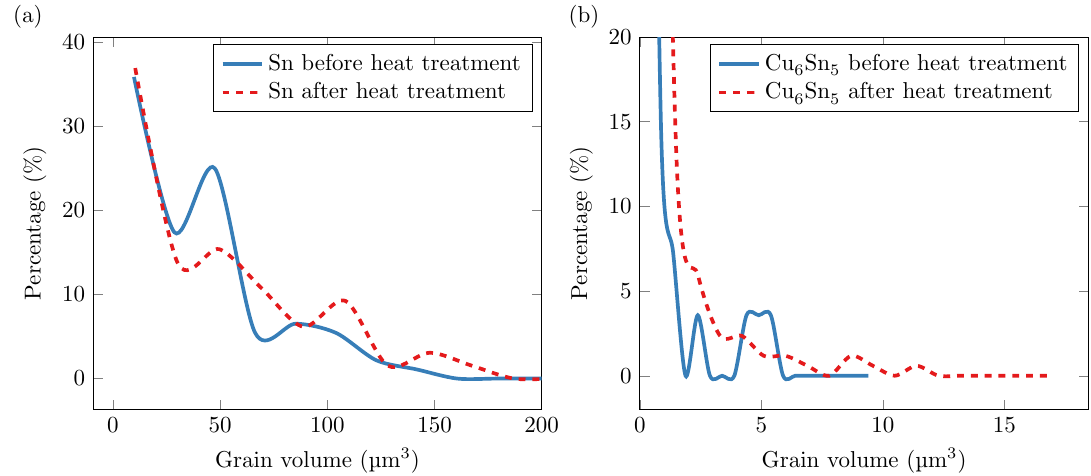
Figure 7. Histograms showing the grain size distribution before and after heat treatment: Sn grains ( a ); and Cu Sn grains ( b 6 5